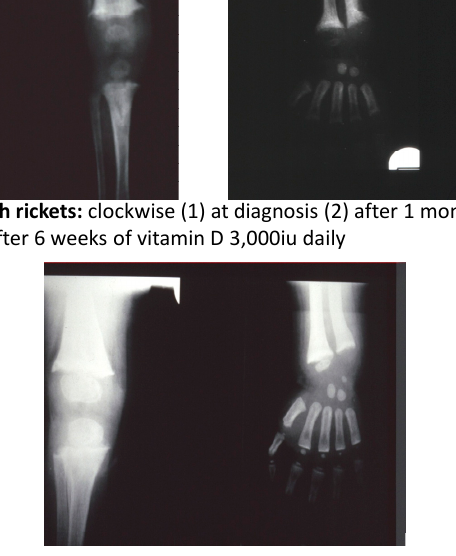
Figure 4. Radiographs of an 18-month-old girl demonstrating the relatively rapid metaphyseal mineralisation within 6 weeks in response to vitamin D treatment and adequate dietary calcium.